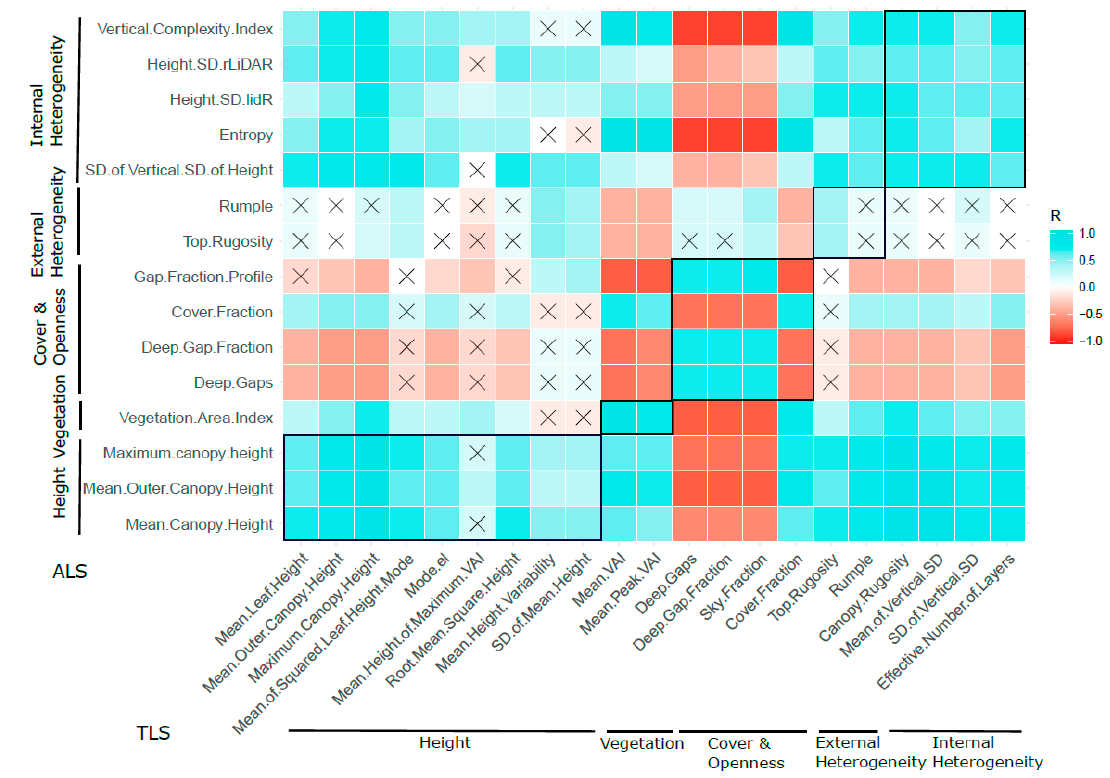
Figure 3. Pairwise Spearman correlation coefficients between aerial laser scanning (ALS) (Y-axis) and terrestrial laser scanning (TLS) metrics (X-axis). Boxes show the paired correlation coefficient results, and the colors of the squares indicate the strength of each correlation; an X indicates a relationship was not significant at α < 0.05. Table 4. Spearman correlations between equivalently estimated structural diversity metrics with terrestrial laser scanning (TLS) and aerial laser scanning (ALS).